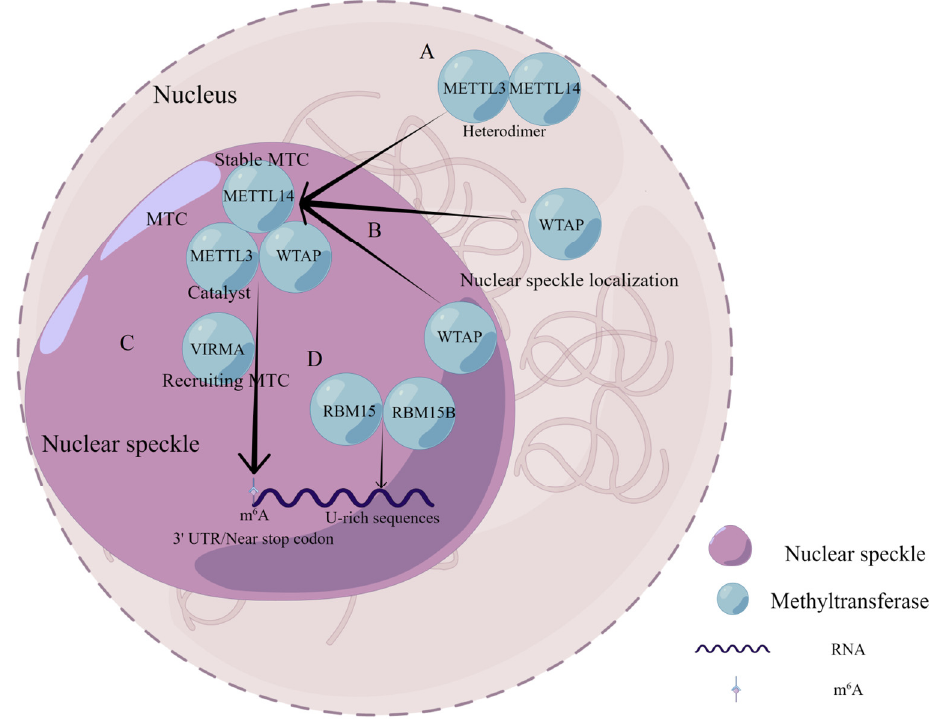
Figure 2. Composition and functional characteristics of MTC in m 6 A modification. ( A ) METTL3 and METTL14 form a stable heterodimer in a 1 to 1 ratio. ( B ) WTAP binds to METTL3 in the nucleus to form the MMW complex and assists in the localization of the complex to the nuclear speckles. ( C ) VIRMA recruits the MMW complex to direct regioselective methylation and mediates preferential mRNA methylation at the 3 (cid:48) UTR, near stop codon. ( D ) RBM15 and RBM15B recruit MTC to their target transcripts by binding directly to U-rich sequences on